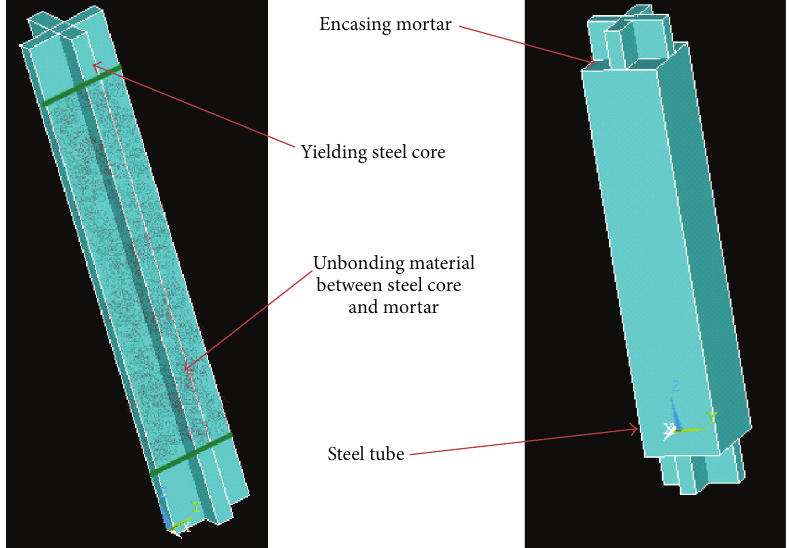
Figure 6: Typical